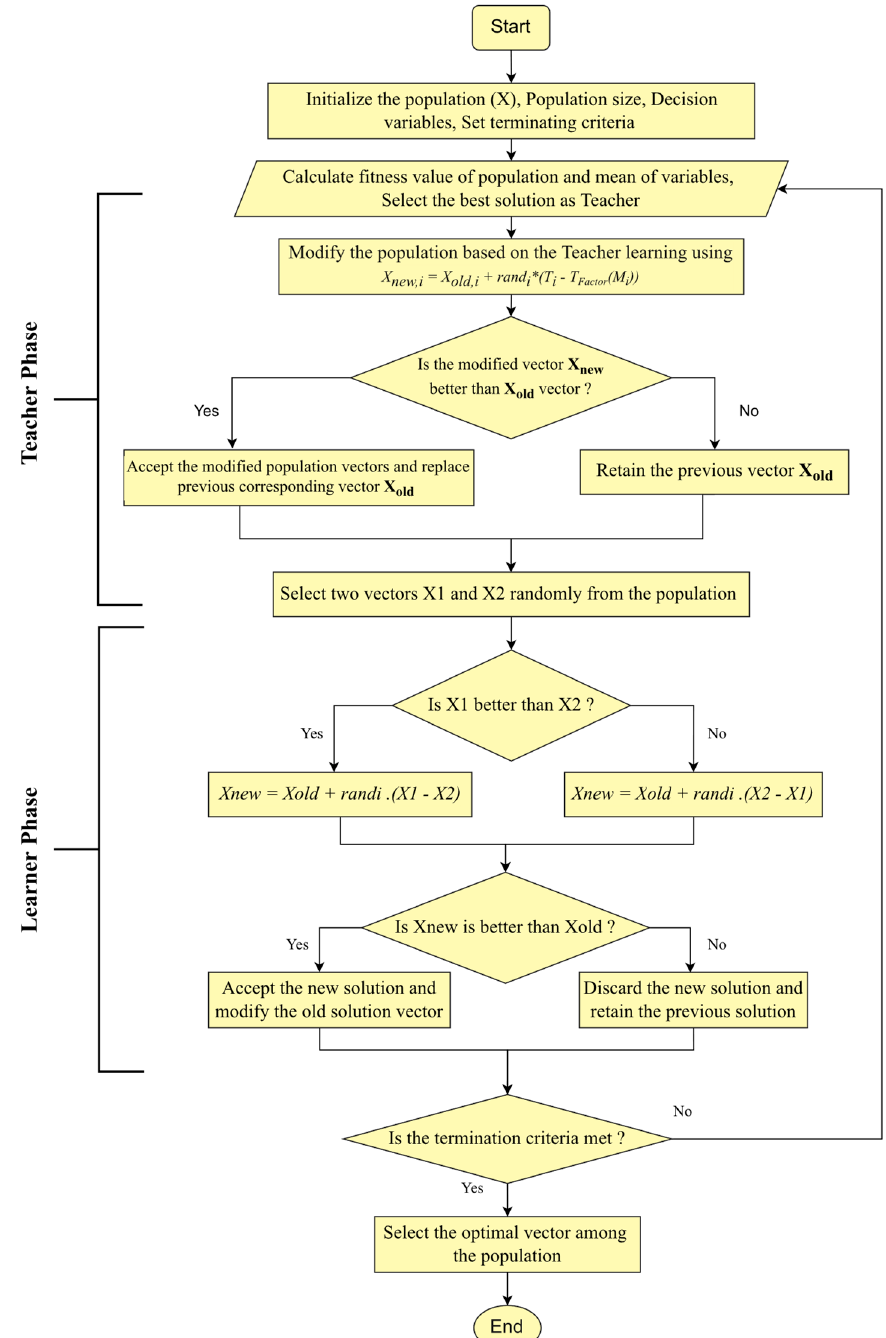
Figure 4. Flow chart of TLBO algorithm.